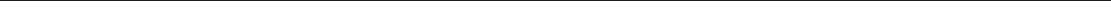
Fig. 4 A global transcriptome-derived map of physiological state transitions demonstrates that diatoms lose ‘ relational resilience ’ as they approach a point of no recovery. All 24 transcriptomes from the fi rst stage (no UVR) of HC and LC conditions were used to identify sets of genes with distinct expression patterns for four physiological states associated with the diurnal cycle and growth phase (see Methods). a Illustrative representation of state descriptor expression distributions (boxplots) with distinct patterns in light (orange) vs. dark (green) or early (blue) vs. late (red) phases of growth and examples of how fi ve hypothetical transcriptomes (markers) would coordinate in relation to the state descriptors. The expression distributions for all state descriptors from the stress test is in Supplementary Fig. 11 and listed in Supplementary Data 1. b A two-dimensional (2D) physiological state space was generated from the differential expression patterns of all state descriptors in stage 1 across both CO 2 conditions (see Methods). The fi ve hypothetical transcriptomes ( a ) are mapped here into the 2D state space based on their expression patterns. For instance, transcriptomes in which state descriptors match an observed light/dark and early/late expression patterns in stage 1 would map to the associated corners of the state space (e.g., square and diamond markers), while a transcriptome in which the state descriptors have mixed expression patterns would localize to the “ non-distinctive area ” of the state space (e.g., both up and down triangles and the circle marker). The sampled transcriptomes of the stress test were mapped to the 2D state space for all stages of the LC ( c ) and HC ( d ) conditions. Replicate transcriptomes are shaded orange (light) or green (dark), based on when they were sampled; open markers represent samples from the early phase and fi lled markers represent late phases of growth (see key). Stages 1, 2, and 3 are represented by a circle, square, and triangle marker, respectively, and arrows illustrate temporal sequence of sampling in each stage and background ellipsoids highlight replicate groupings. Dashed circles represent 1.96 standard deviations from observed state positions in stage